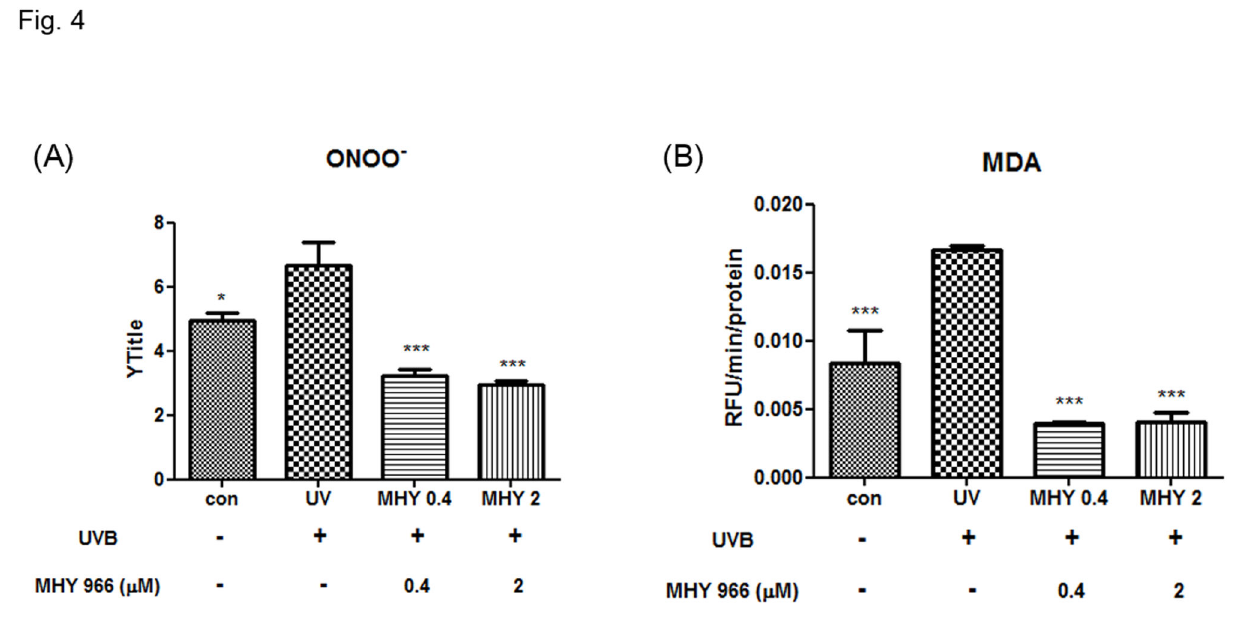
Figure 4. Effects of MHY 966 on UVB-induced ONOO - and MDA in HRM2 mouse dorsal skin. ONOO - was measured by DHR-123 with a fluorescent probe (A) and MDA was measured by TBARS assay (B) in HRM2 mouse dorsal skin. Bar represent means ± SEMs of six mice and normalized mg/protein. *** P < 0.001, ** P < 0.01 and * P < 0.05 versus UVB-exposed mice. doi: